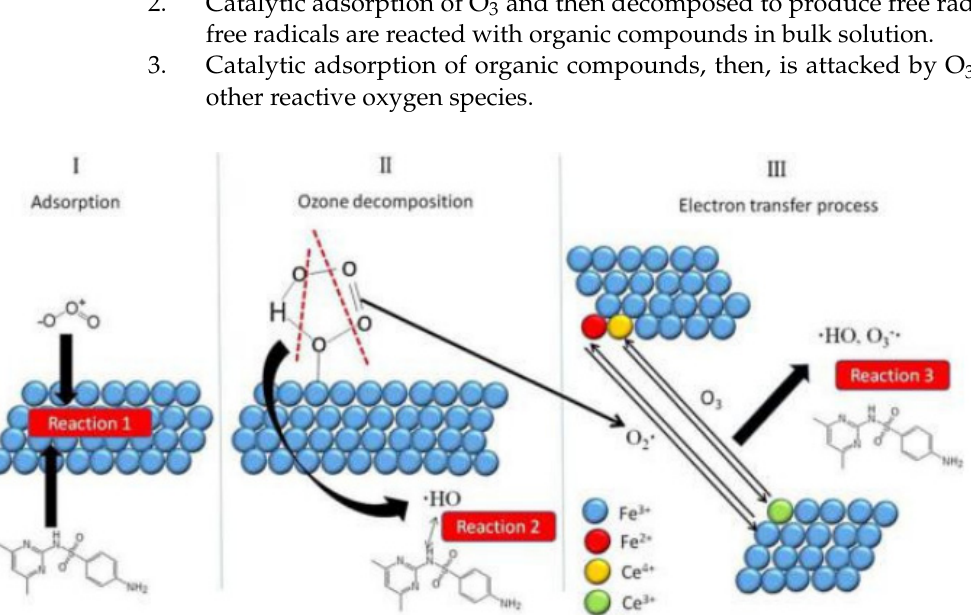
Figure 18. Schematic of possible mechanisms for heterogeneous catalytic ozonation. Reproduced from Ref. [118]. Copyright 2019 MDPI.